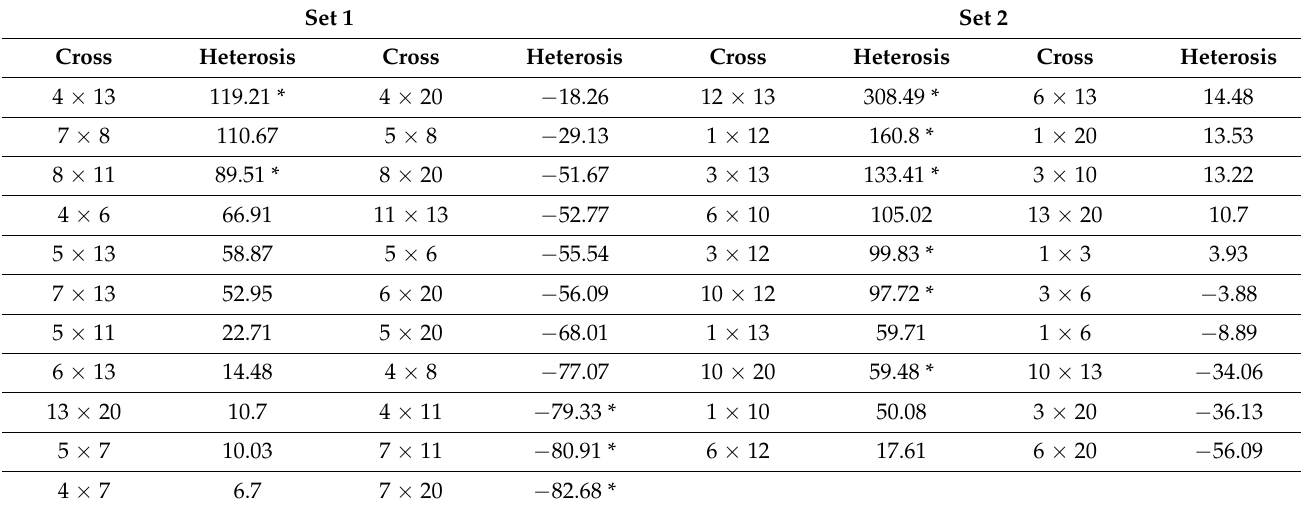
Table 6. Best parent heterosis percentage of market yield for the experimental hybrids in Set 1 and Set 2. For each set, values are presented in decreasing order. Set 1 Set